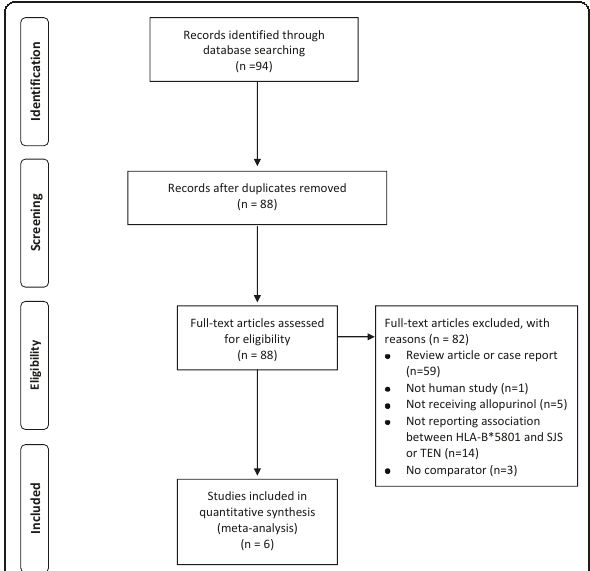
Figure 1 A flow diagram for study identification, inclusion and exclusion